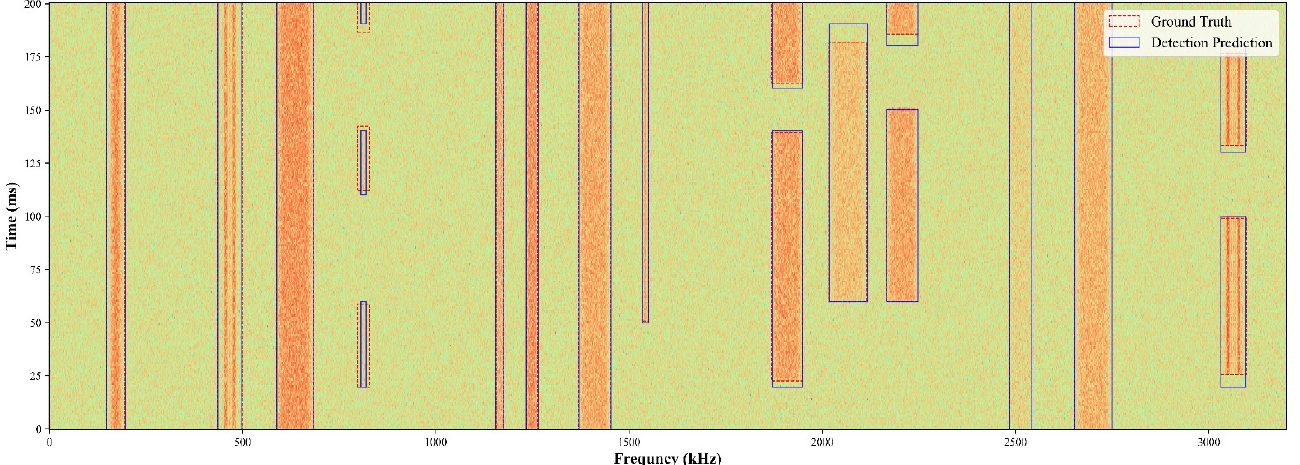
Figure 7. The first example of the FFSCN-FMN detection results. Here, the signal time duration is 200 ms, and we split it into 200 consecutive frames of the broadband power spectra and grouped them into 20 FFSCN-FMN inputs without frame overlap.